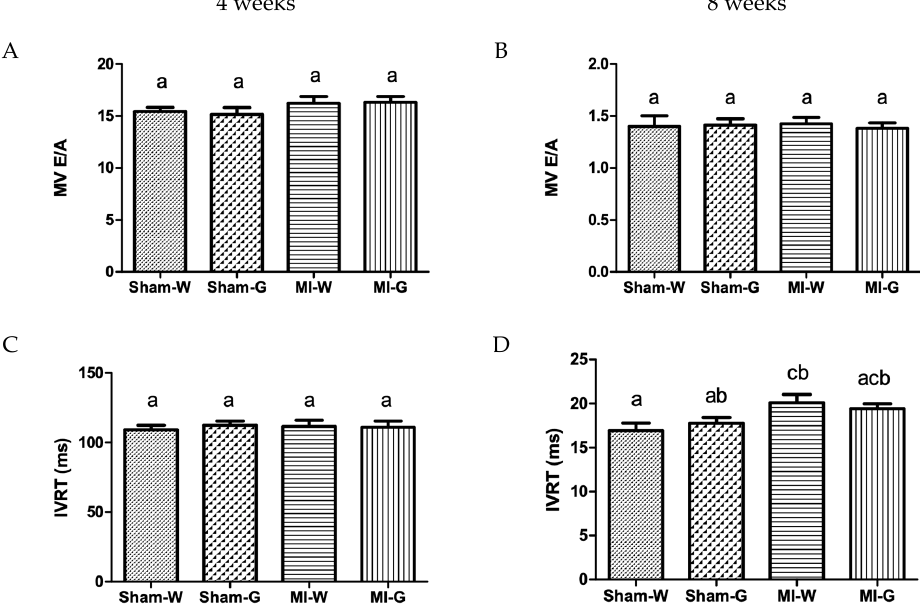
Figure 4. Effect of ginseng berry extract on diastolic heart function. ( A ) Mitral valve E- to A- wave ratio (MV E/A) at 4 weeks; ( B ) MV E/A at 8 weeks; ( C ) Isovolumic relaxation time (IVRT) at 4 weeks; ( D ) IVRT at 8 weeks. Values presented are mean ± SEM. Bars with differing letter are significantly different, p < 0.05. Sham-W: Sham MI treated with distilled water ( n = 8); Sham-G: Sham MI treated with GBE 150 mg/kg/body weight/day ( n = 8); MI-W: MI treated with distilled water ( n = 12–14); MI-G: MI treated with GBE 150 mg/kg/body weight/day ( n = 12–14).